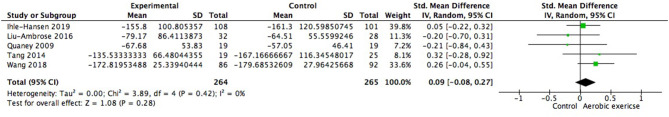
Meta-analysis of impact of aerobic exercise on set shifting.